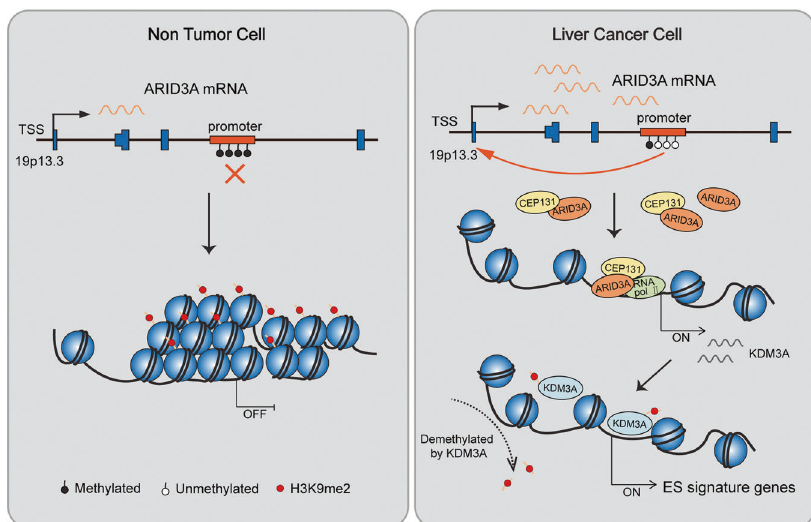
Fig. 8 Schematic overview of the mechanism of ARID3A in regulation of ES signature gene in liver cancer. ARID3A has a relative low expression in normal liver cells. We found that ARID3A is upregulated in liver cancer patients, which is at least in part mediated by DNA demethylation at the ARID3A gene locus (19p13.3, chromosome 19, p arm, band 1, sub-band 3, and sub-sub-band 3). ARID3A interacts with CEP131 and co-occupies the KDM3A promoter region and drive the expression of KDM3A, which demethylates H3K9me2 in the promoter regions of ES signature genes. These events lead to upregulation of ES signature gene expression, facilitating liver cancer